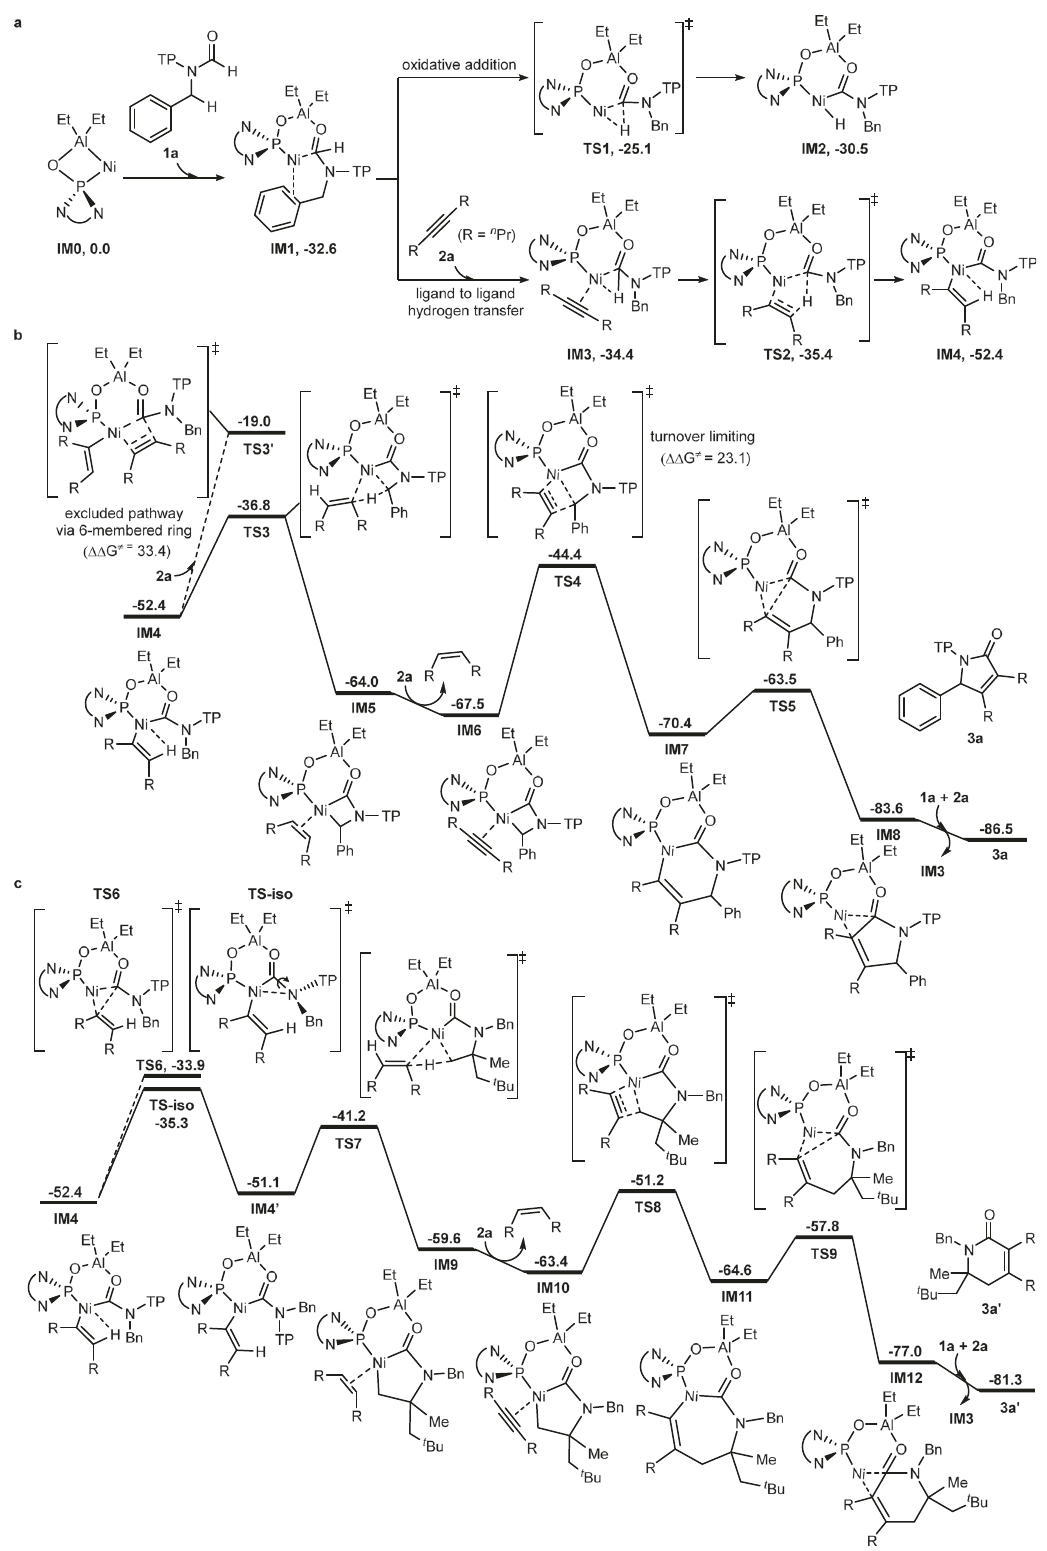
Fig. 6 | DFTcalculations. The computations were performedat the B3LYP-D3(BJ)/ def2- TZVPP-SMD (toluene) //B3LYP-D3(BJ)/def2-SVP level of theory. a Comparison between oxidative addition and ligand-to-ligand H transfer for formyl C – H bond activation, and the result shows that the latter is a preferred pathway. b Product-